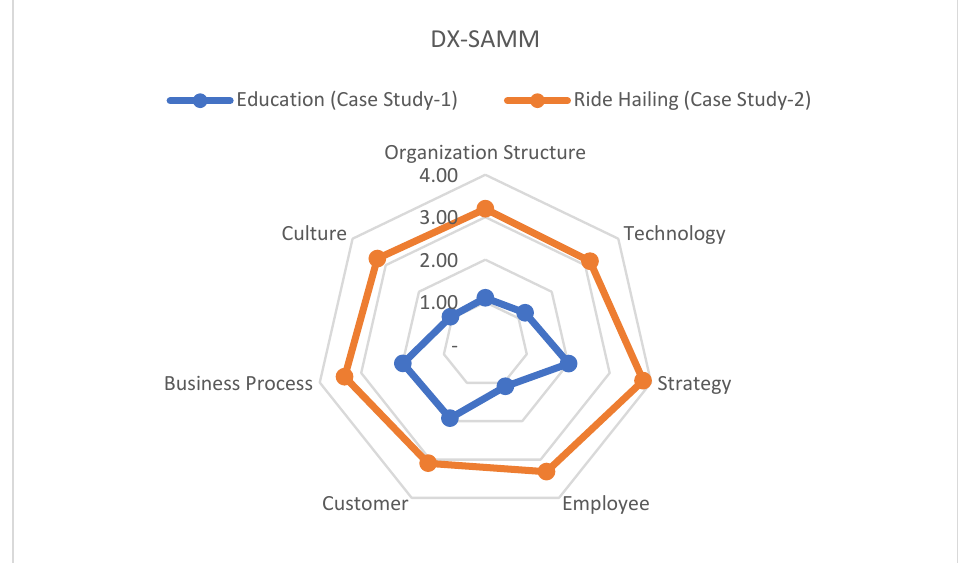
Figure 10. Cross-case Maturity Level Comparison. Table 6. Maturity Gaps Across Case Studies.